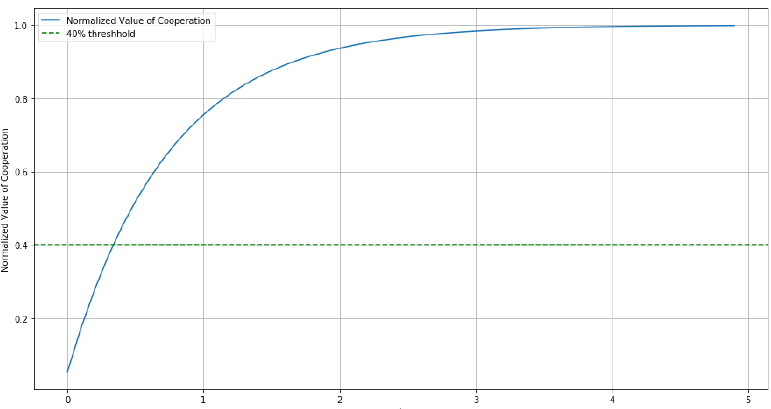
Figure 12. Normalized Value of